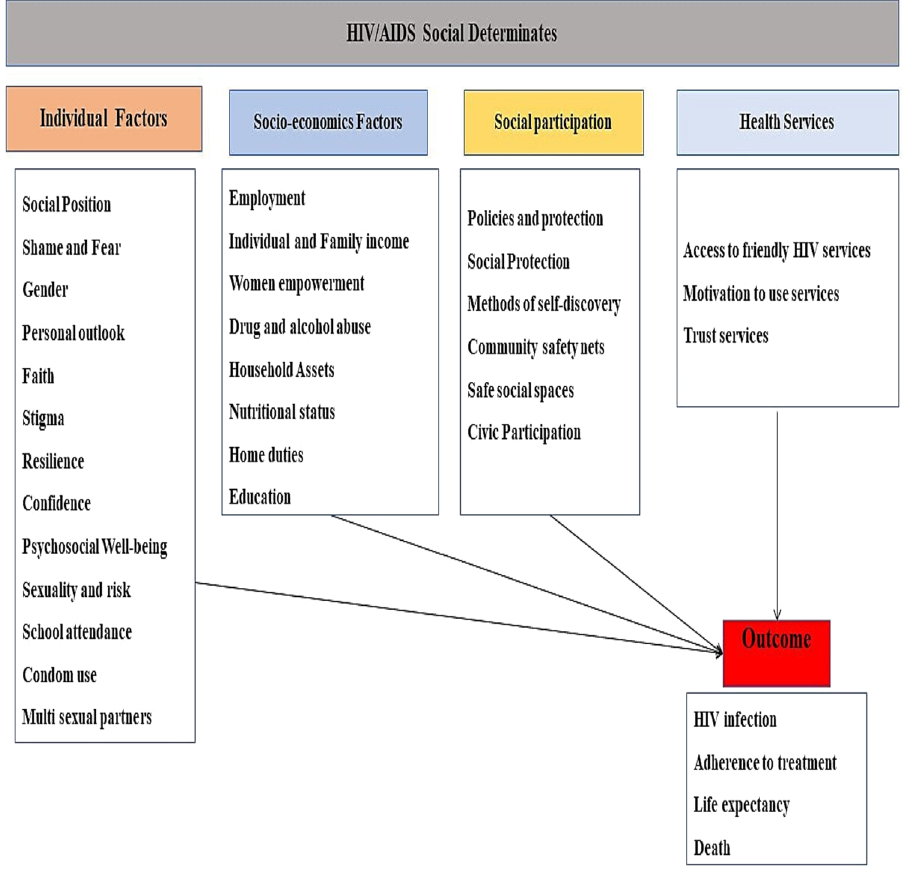
Figure 1. Social determinants of health for HIV/AIDS derived from narrative